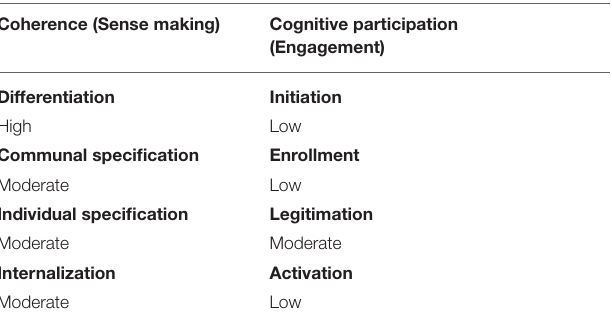
TABLE 2 | Appraisal of the level of each NPT constructs based on a summative evaluation of the data from the project (Phase Five summary). Coherence (Sense